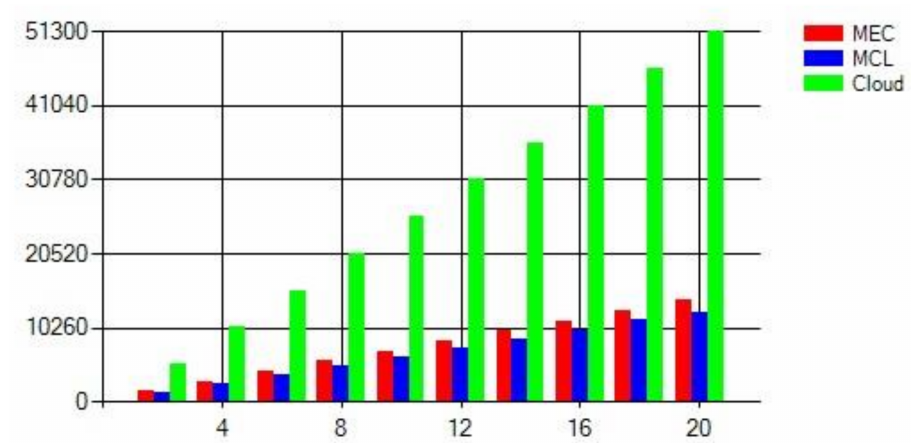
Figure 14. The total processing time of the MCL, MEC, and